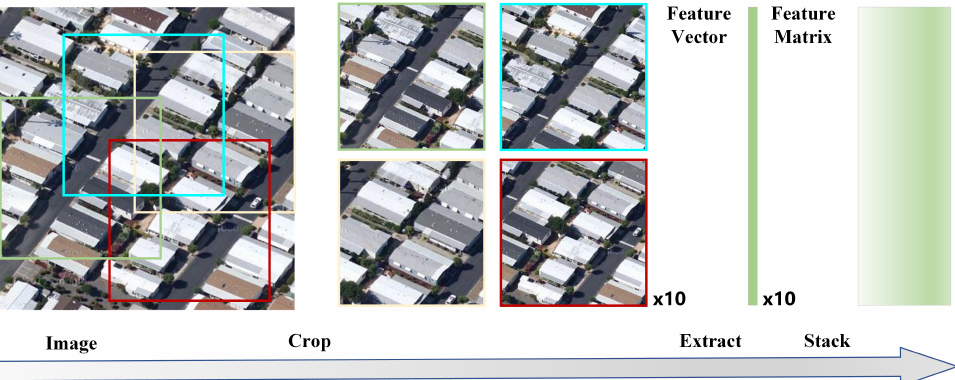
Figure 4. The illustration of first step for preprocessing. A single image is “cropped-extracted-stacked” to produce a feature